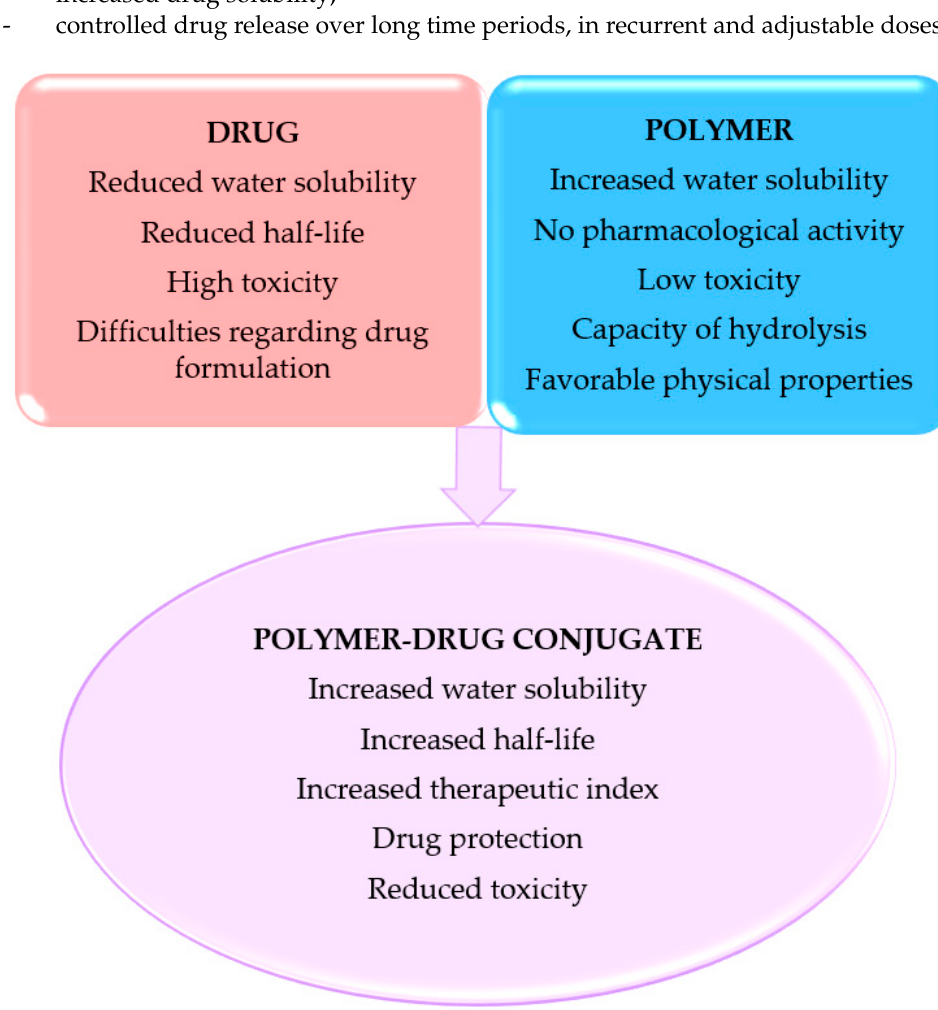
Figure 2. Improved properties of polymer–drug conjugate [8,22].